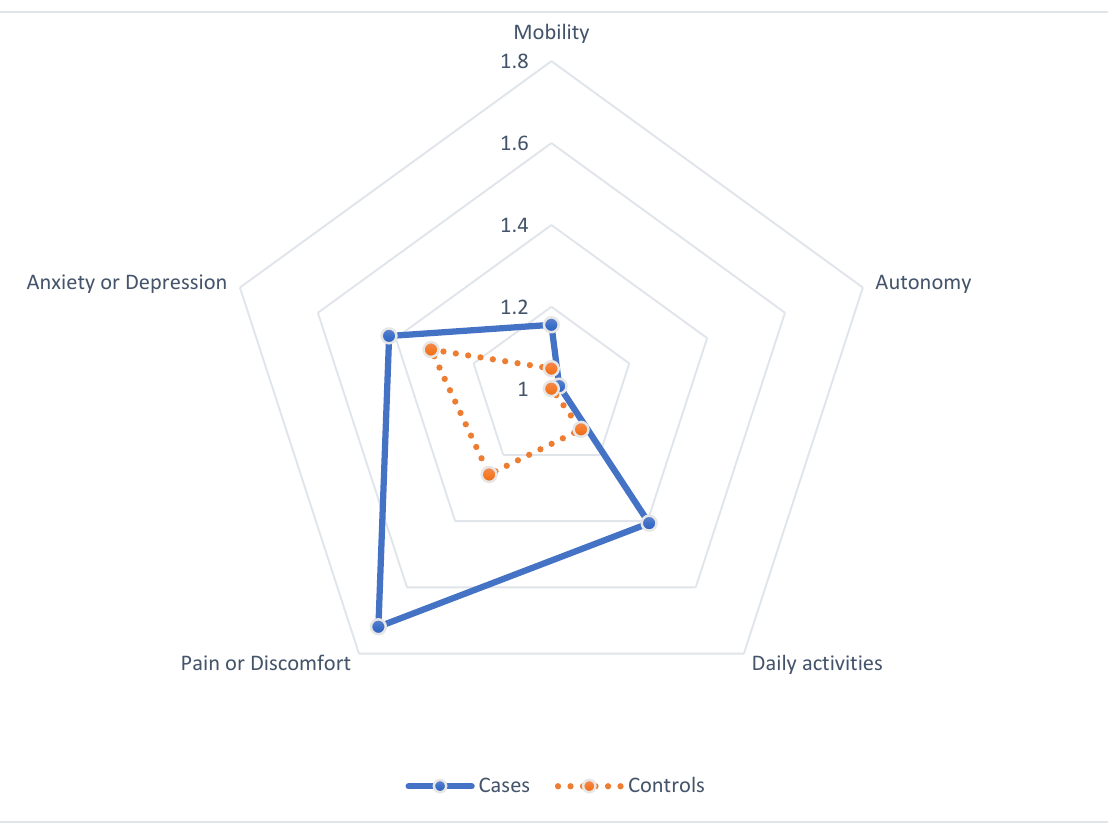
Figure 2. Each domain of EQ-5D-5L score.